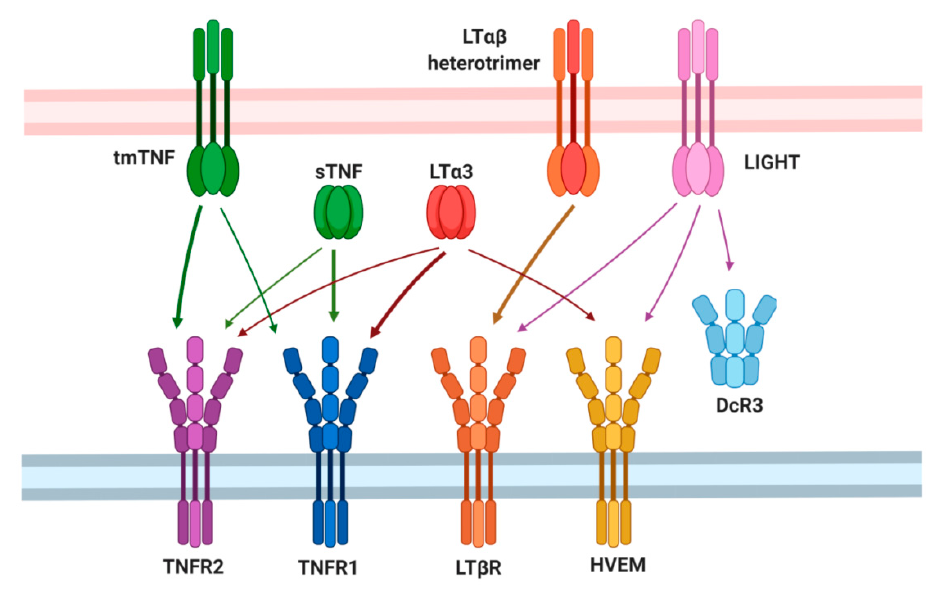
Figure 1. Ligands and receptors of the tumor necrosis factor (TNF)/lymphotoxin (LT) axis. Tumor necrosis factor (TNF) exists in either soluble (sTNF) or trans-membrane (tmTNF) form and interacts with its two receptors: TNFR1 (TNFp55) and TNFR2 (TNFp75). Another ligand for TNF receptors (TNFRs) is lymphotoxin α homotrimer (LT α 3) that, in addition, binds herpes virus entry mediator (HVEM). HVEM, lymphotoxin β receptor (LT β R), and decoy receptor 3 (DcR3) are receptors for LIGHT, while LT β R also interacts with LT αβ heterotrimer, a membrane-bound form of lymphotoxin.